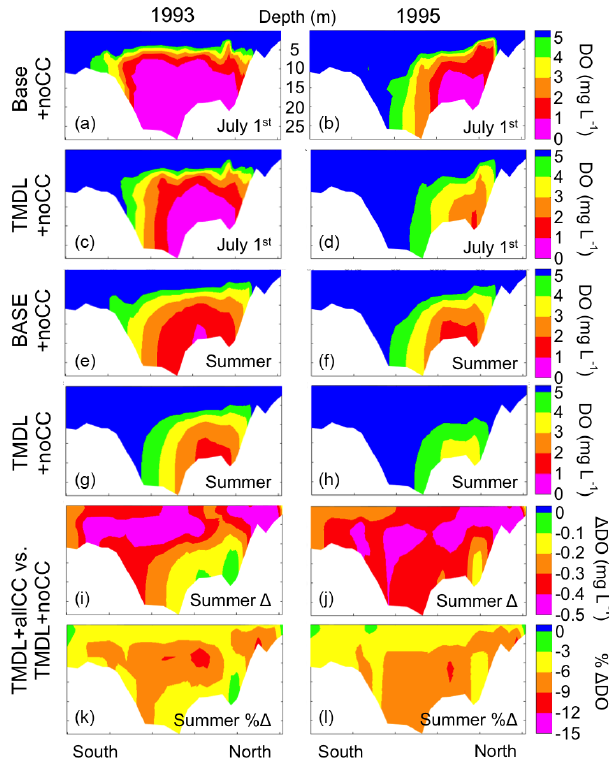
Figure 8. Latitudinal along-bay DO transects for the Base + noCC run and TMDL + noCC scenario for 1 July 1993 (a, c) and 1 July 1995 (b, d) and average summer (May–September) for 1993 (e, g) and 1995 (f, h) ; the difference in average summer DO between the TMDL + noCC and TMDL + allCC scenarios (i, j) and the per- cent difference in average summer DO between the TMDL + noCC and TMDL + allCC scenarios (k, l)